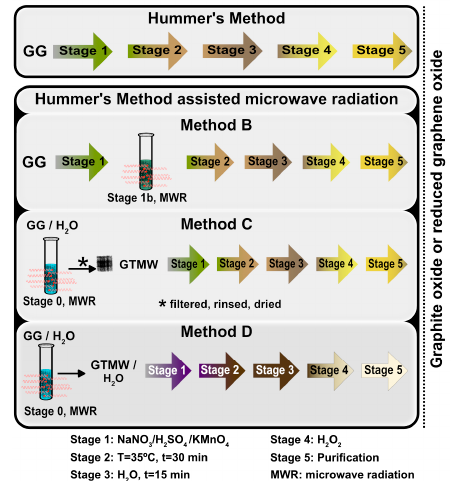
Figure 1. Schema of reactions of the different methodologies.